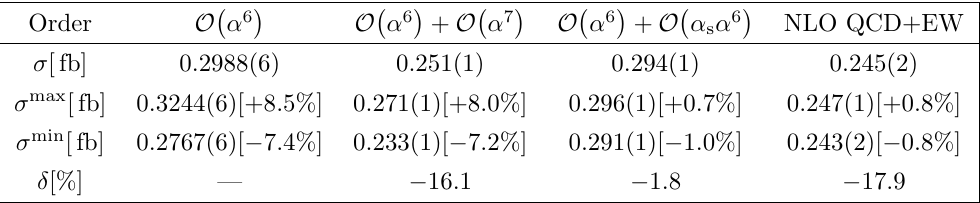
Cross sections for pp (cid:22) + (cid:22) (cid:0) e + (cid:23) e jj + X at the LHC with CM energy 14 TeV at ! LO [ O ]. Each contribution is given in fb (with the extrema resulting from scale variations as absolute numbers and as deviation in percent) and as relative correction (cid:14) = O ( (cid:11) 6 ) (cid:27) NLO =(cid:27) in percent. The digits in parentheses LO indicate the integration